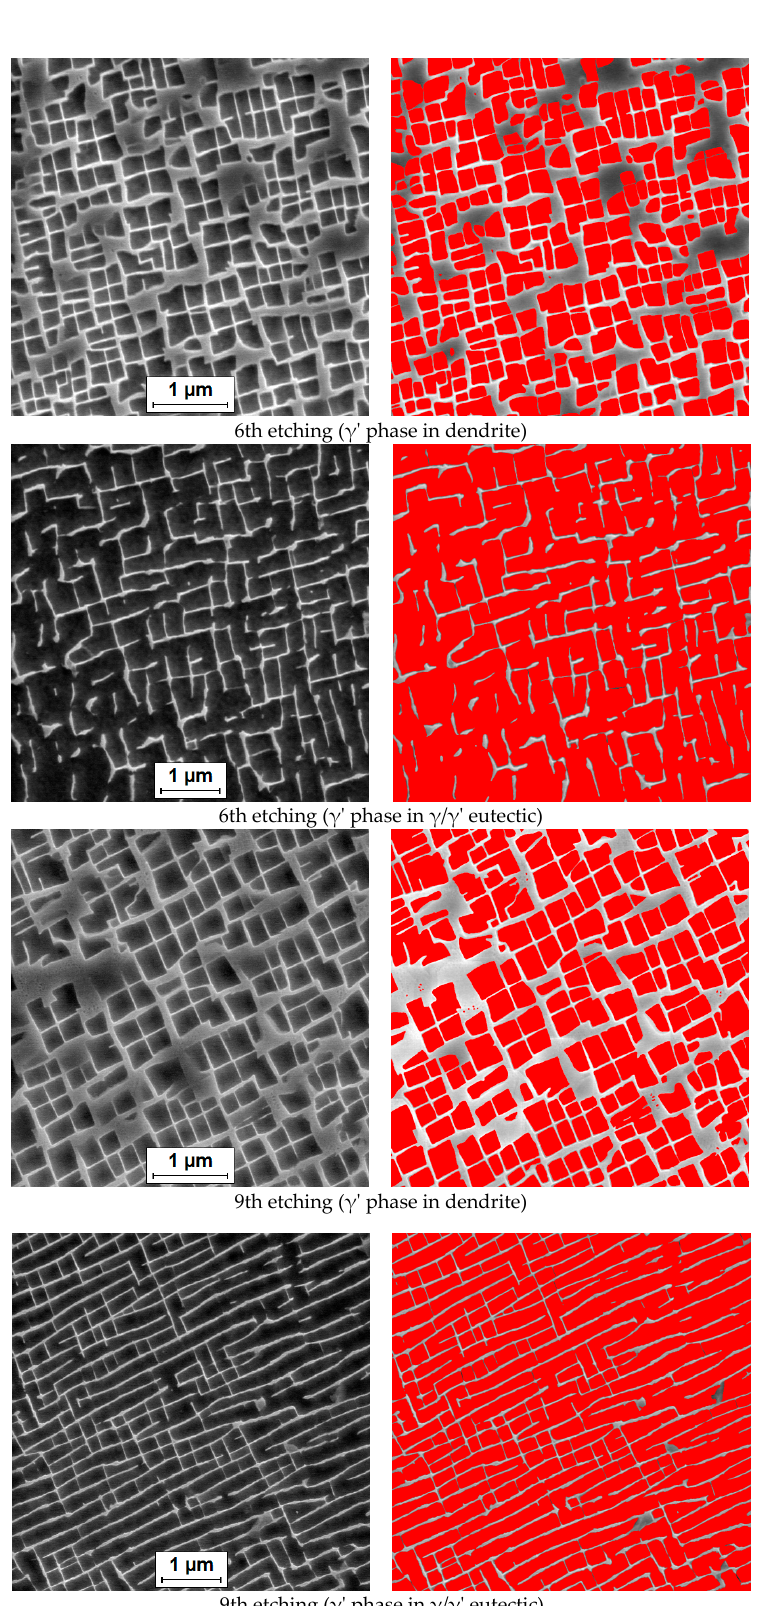
Figure 3. The raw images of the CMSX-4 superalloy and the final images with detected microareas for a quantitative analysis. The microareas of the CMSX-4 selectively etched to remove γ ’ phase (left), segmentation of the γ ’ phase (right, with coloured overlay).